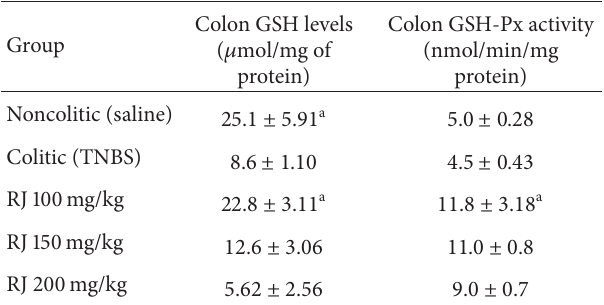
Table 2: Effect of royal jelly on colonic GSH level and GSH-Px and GR activities in TNBS-induced colitis in mice.